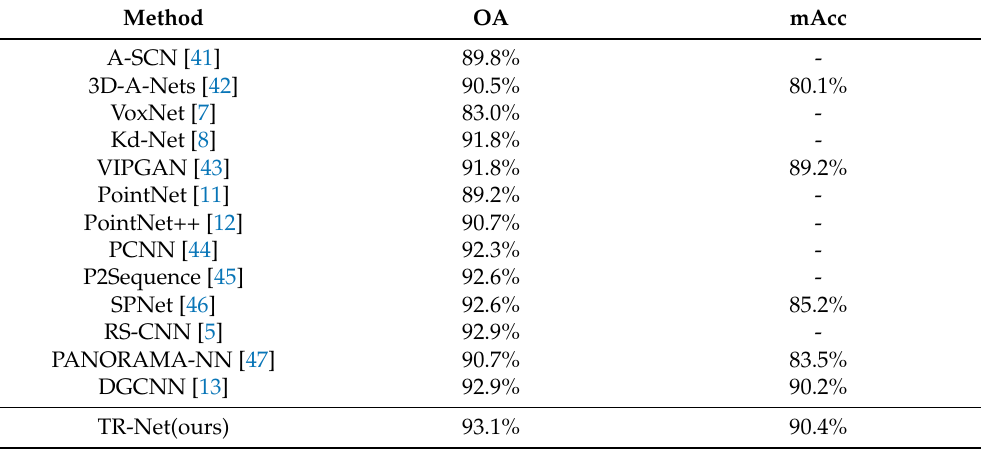
Table 3. Comparison with other approaches on ModelNet40 classification dataset. OA indicates overall accuracy. mAcc denotes mean class accuracy.